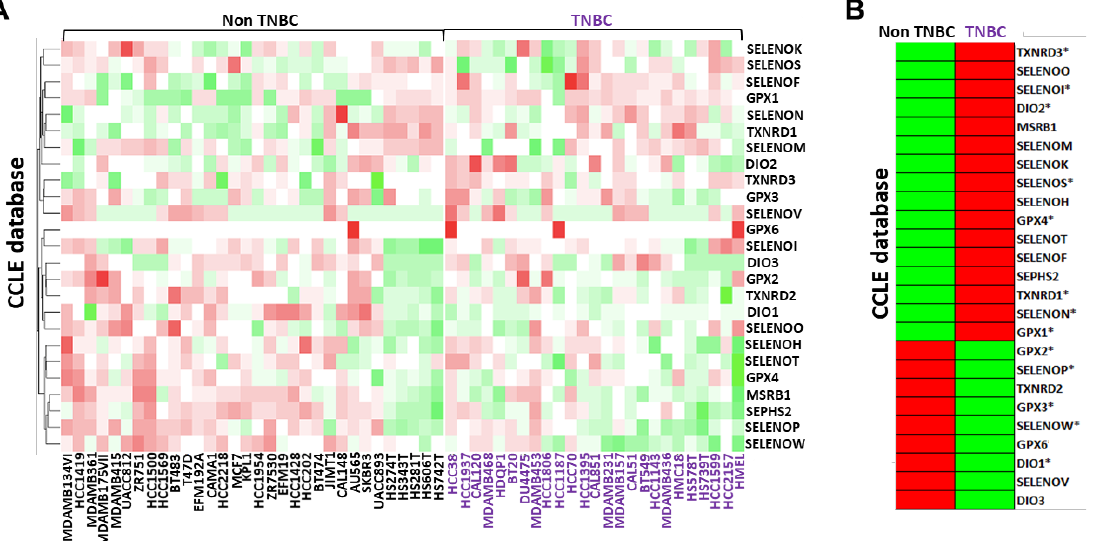
Figure 1. Comparison between the gene expression profiles of each selenoprotein in breast cancer cell lines subdivided between TNBC and “non - TNBC” subgroups and their related mean expres- sion profiles by clustering analysis obtained using RNAseq data in the CCLE database ( A , B ). The color scale from green to red refers to lower and higher gene expression levels of selenoproteins, respectively. We evidenced with * the selenoproteins that presented similar expression trends in both the CCLE and LINCS datasets.